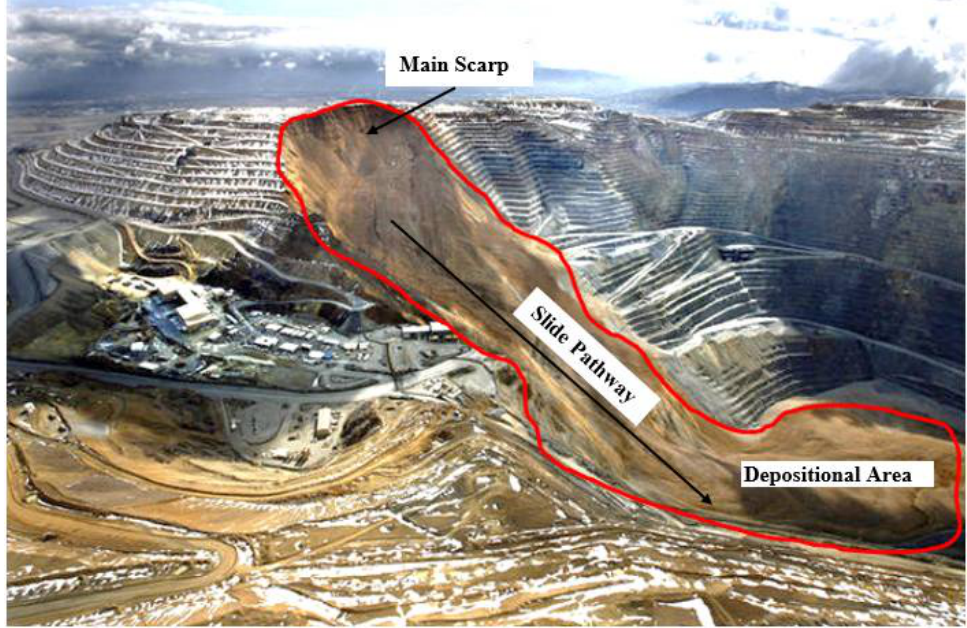
Figure 16. Image of landslide at Kennecott Utah Copper’s Bingham Canyon Mine (Adapted from [113]).